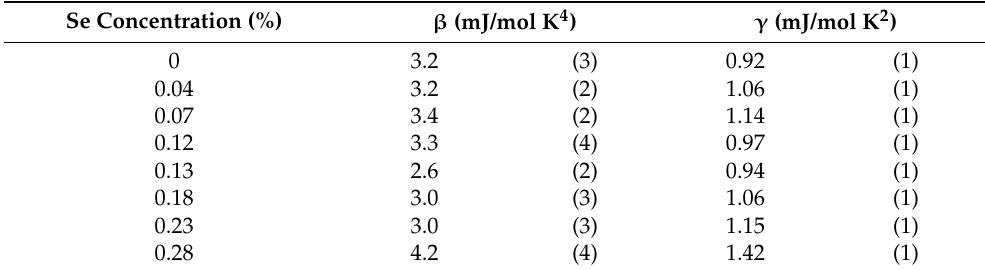
Figure 6. C p / T as a function of T 2 for the single crystal samples. Each solid line indicates a fitting. Table 2. Fitting parameters used in Figure